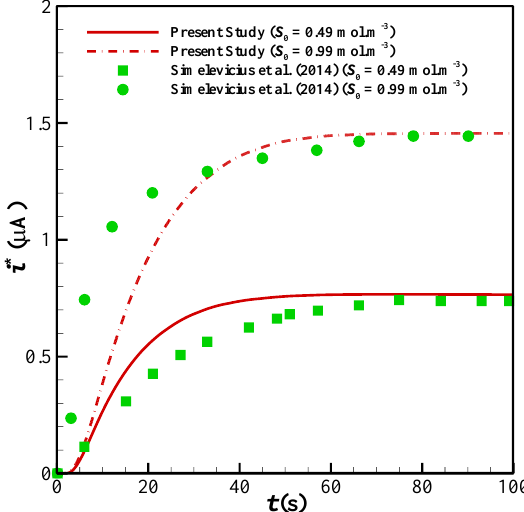
Figure 6. Comparison between the results of the present study with the experimental data of [31]; variation in the dynamic current of the biosensor with time and for two substrate concentrations: S 0 = 0.49 and 0.99 mol/m 3 .